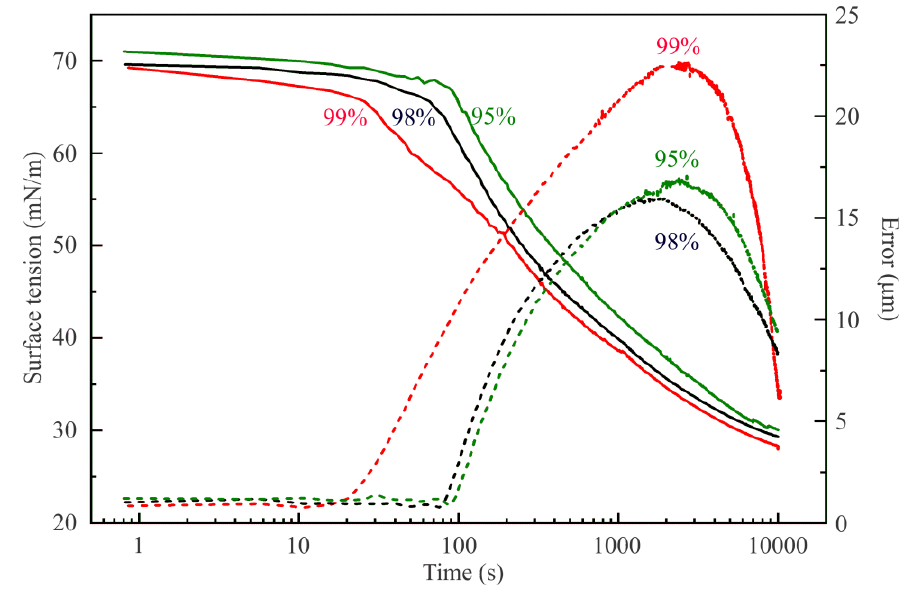
Figure 1. Dynamic surface tension (solid lines) and fitting errors (dashed lines) for water drops in hexane vapor of different purity of 99%, 98%, and 95%, as labelled in the figure.